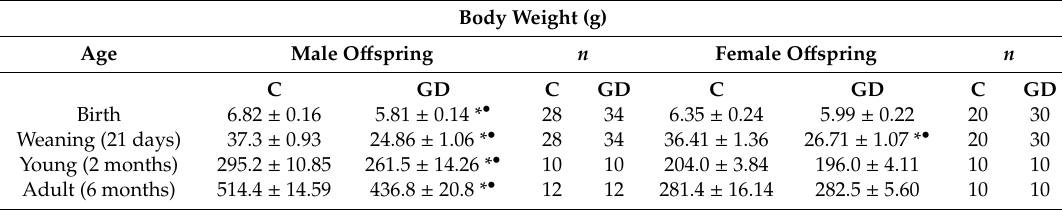
Table 2. O ff spring body weight at di ff erent